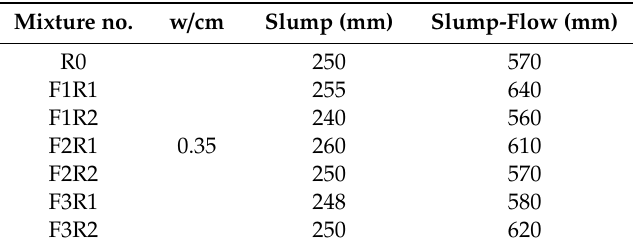
Table 3. The slump test results of fresh concrete.